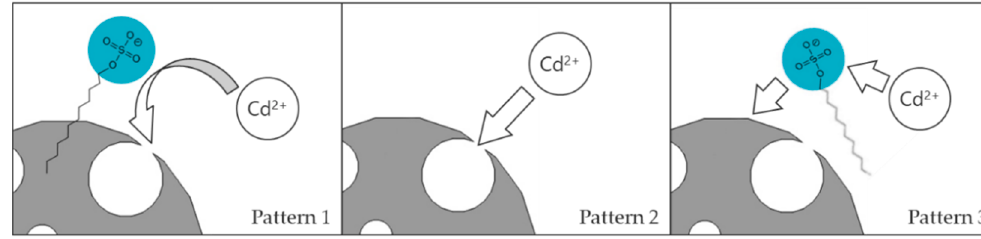
Figure 6. Reaction mechanism that cadmium ions are attracted/absorbed by SDS and AC.